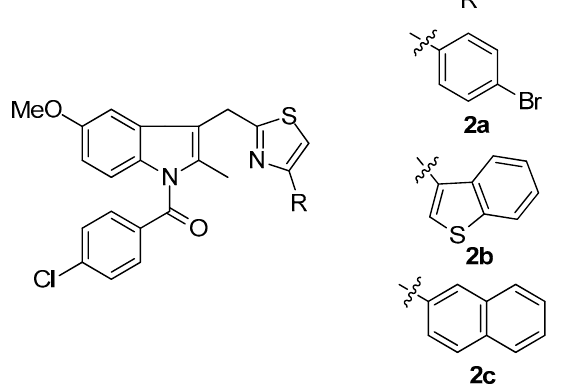
Figure 3. Chemical structures of 4-substituted thiazole analogues of indomethacin 2a – c .